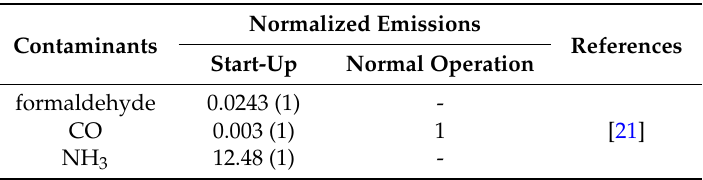
Table 3. Emissions from a nuclear power generation facility under start-up and normal operating conditions (number of facilities investigated shown in